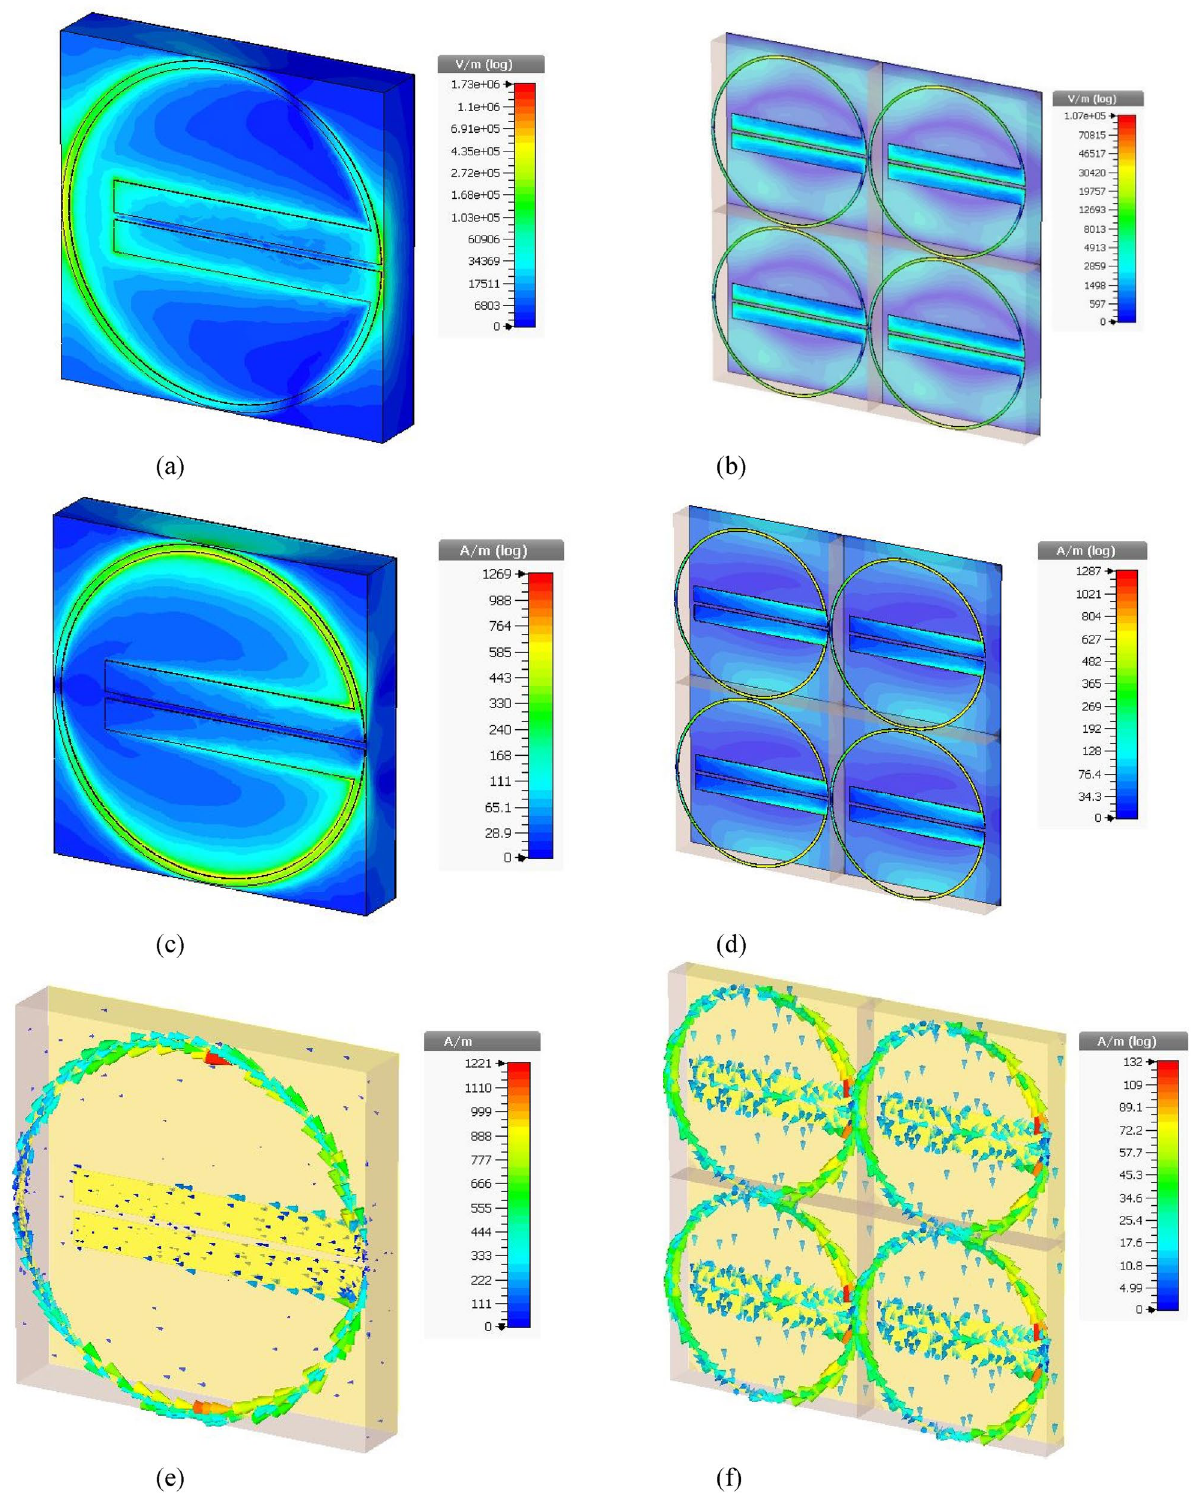
Figure 5. The electric field distribution of ( a ) the unit cell and ( b ) the array. The magnetic field distribution of ( c ) the unit cell and ( d ) the array. The surface current distribution of ( e ) the unit cell and ( f ) the